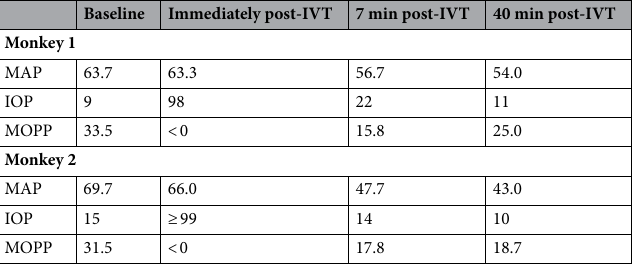
Table 1. Summary of Mean arterial pressure (MAP), Intraocular pressure and Mean ocular perfusion pressure (MOPP) at baseline, immediately post-intravitreal injection (IVT), 7 minutes post-IVT and 40 minutes post- IVT. MAP mean arterial pressure (MAP = DBP + 1/3(SBP-DBP), IOP intraocular pressure, MOPP mean ocular perfusion pressure MOPP = 2/3(MAP)-IOP, DBP diastolic blood pressure, SBP systolic blood